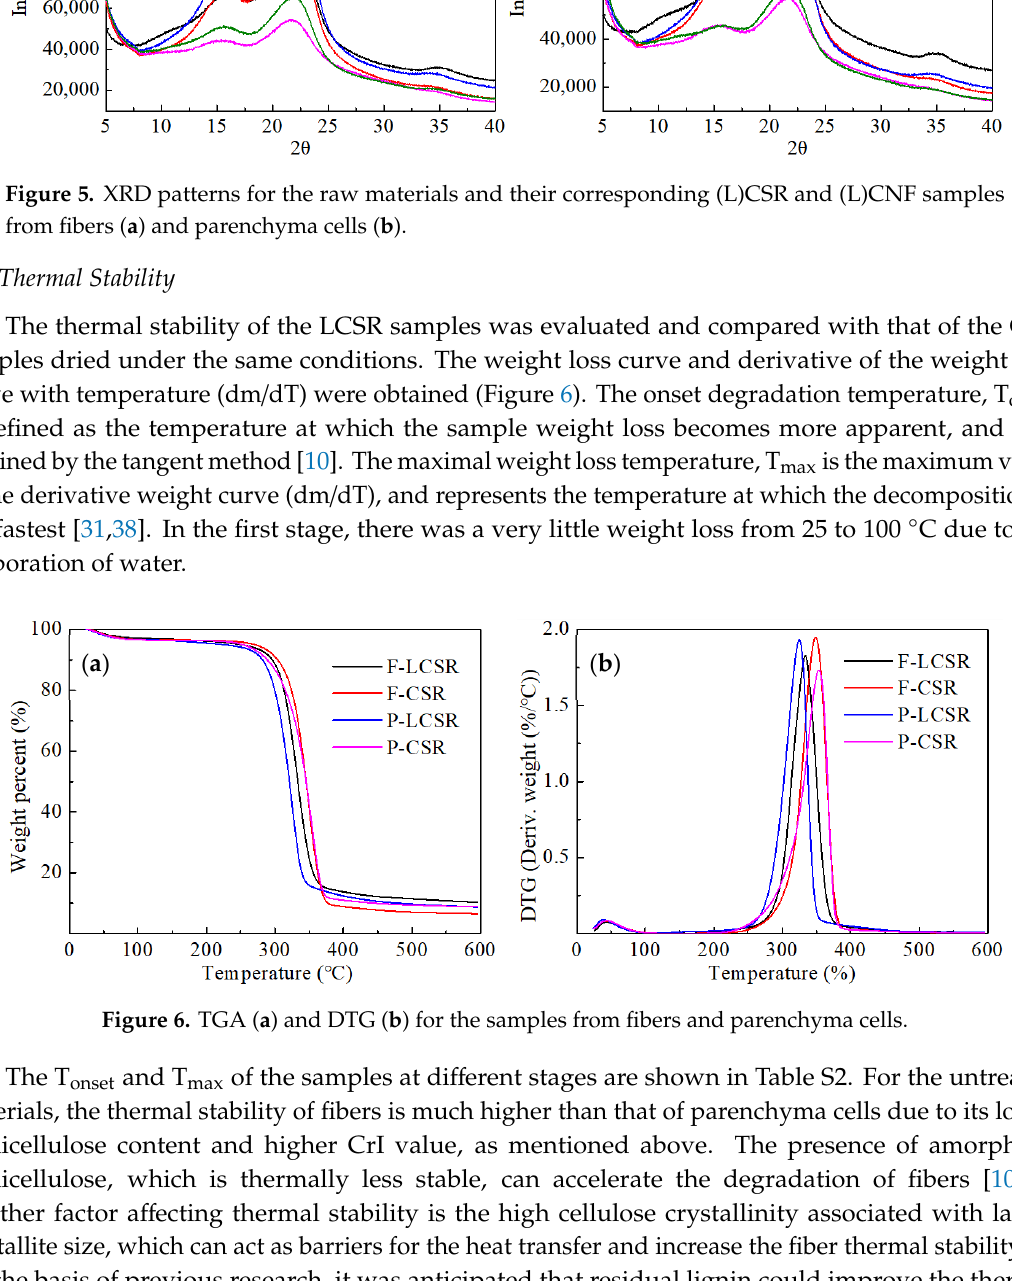
Figure 6. TGA ( a ) and DTG ( b ) for the samples from fibers and parenchyma cells.